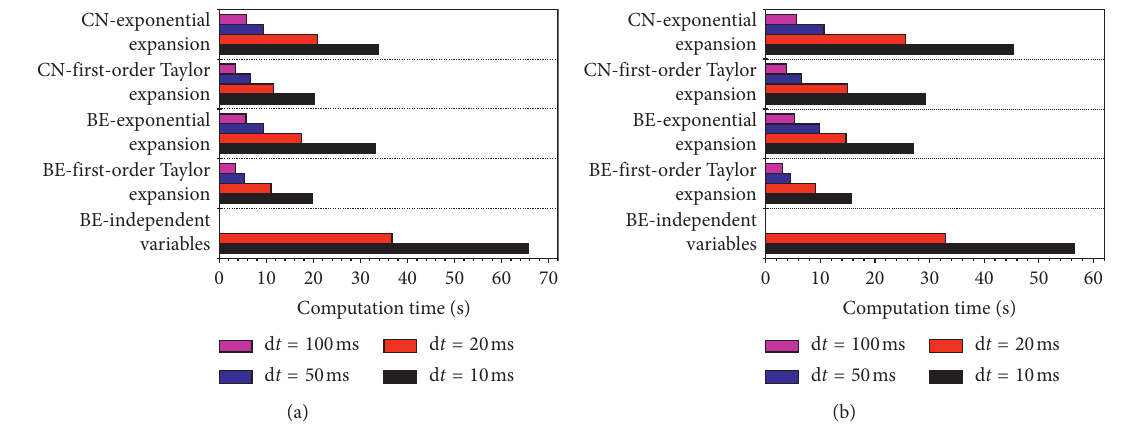
Figure 3: Relative power error of TWIGL reactivity insertion problem in Δ t � 10